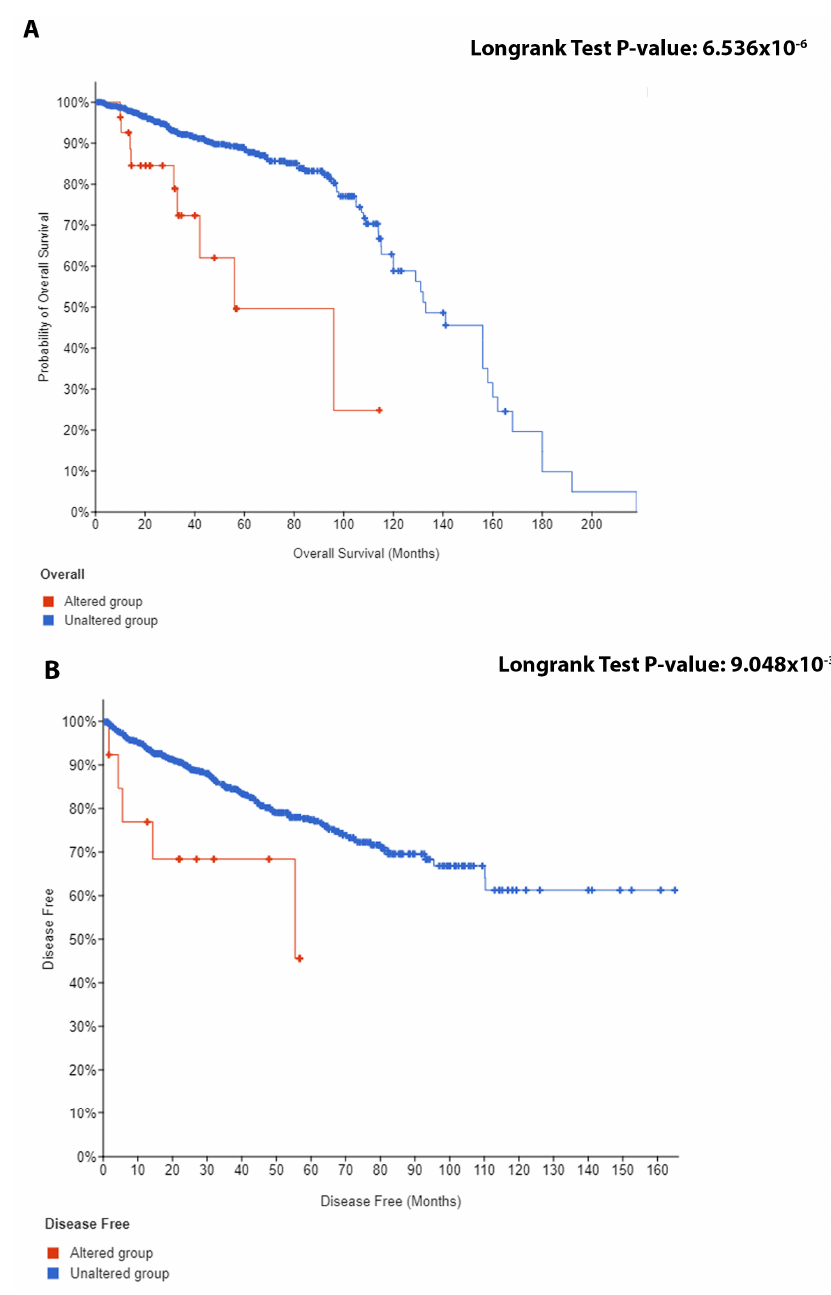
Figure 2. The Kaplan–Meier (KM) curves for GARS genomic alteration for ( A ) PCa overall survival and ( B ) PCa disease-free survival. Data were obtained from cBioportal (contains 5015 samples). Genomic alteration includes any of the mutations (Missense, in frame, truncating, other), structural variant/fusion, and copy number alteration in the GARS gene.